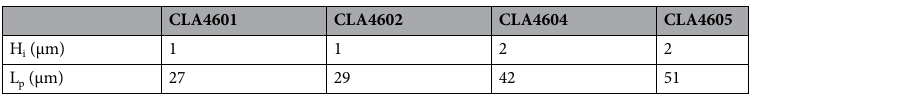
Table 1. Structural parameters of the CLA4601, CLA4602, CLA4604 and CLA4605 silicon limiter